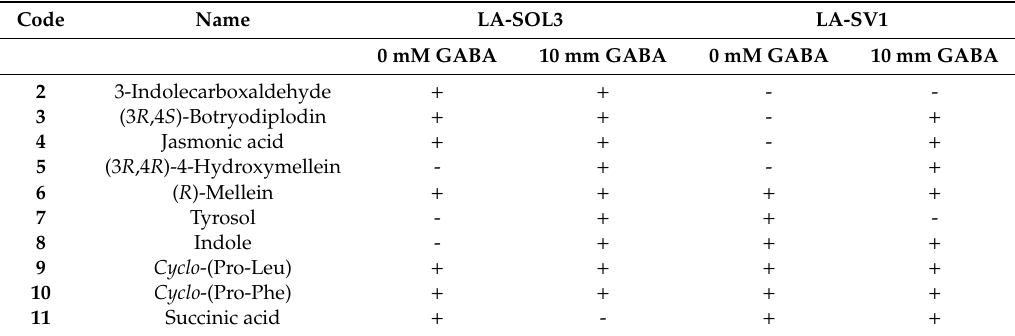
Table 2. Distribution of minor secondary metabolites produced by strains LA-SOL3 and LA-SV1, according to strain and γ -aminobutyric acid (GABA)